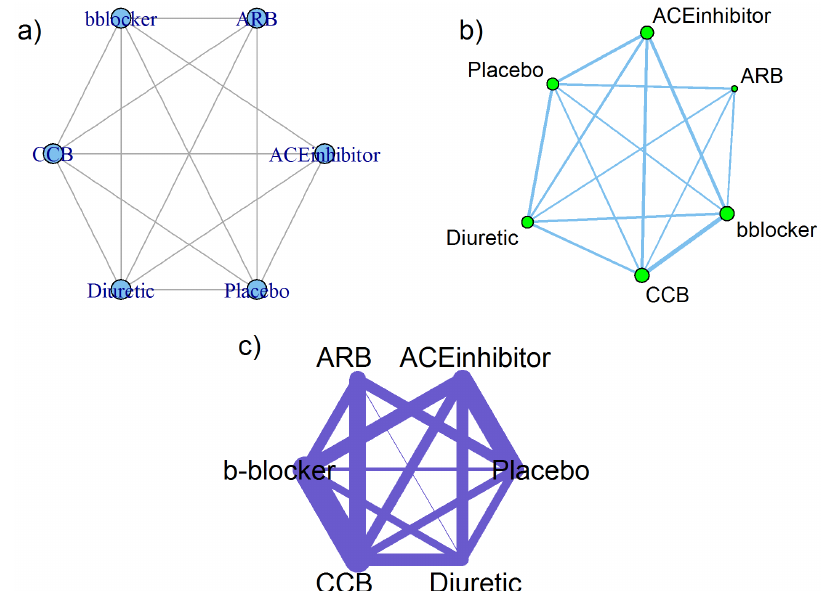
Fig. 1. Network plots created by R packages a) gemtc , b) pcnetmeta , and c) netmeta .